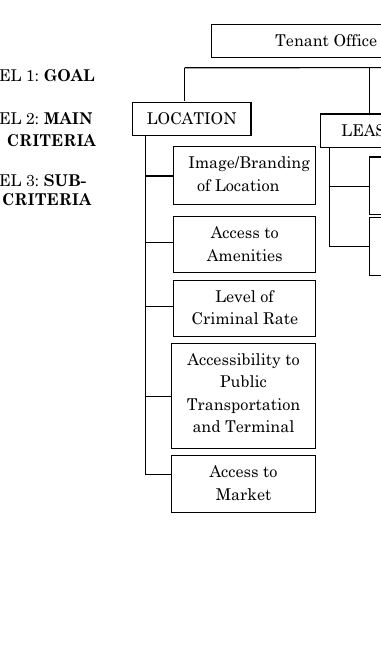
Fig. 1. Office space preference hierarchy framework Table 2. Overall and group mean sub criteria weights Main